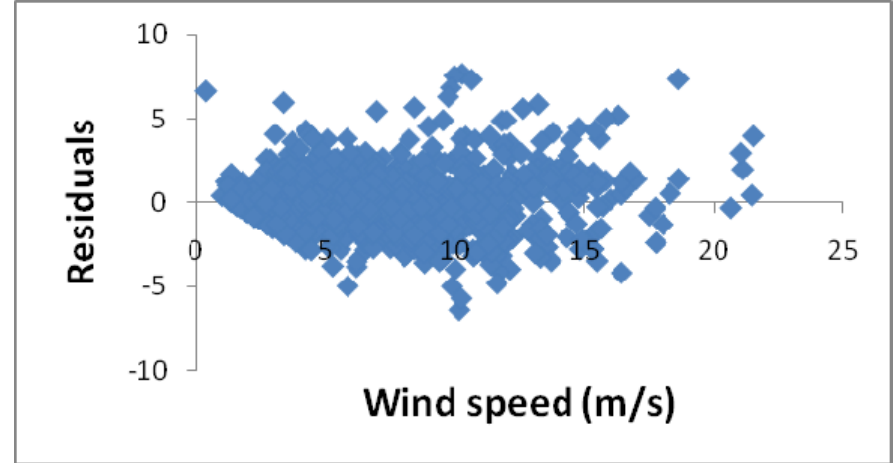
Figure 6. Residual plot for the linear regression on wind speed from masts versus SAR wind maps.